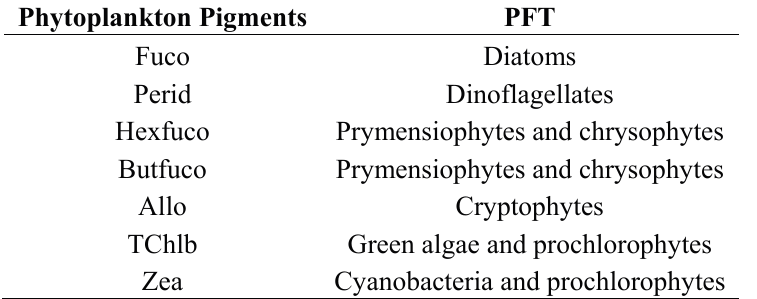
Table 2. Phytoplankton pigments and their respective PFT (adapted from Vidussi et al. [17]). Phytoplankton Pigments PFT Fuco Diatoms Perid Dinoflagellates Hexfuco Prymensiophytes and chrysophytes Butfuco Prymensiophytes and chrysophytes Allo Cryptophytes TChlb Green algae and prochlorophytes Zea Cyanobacteria and